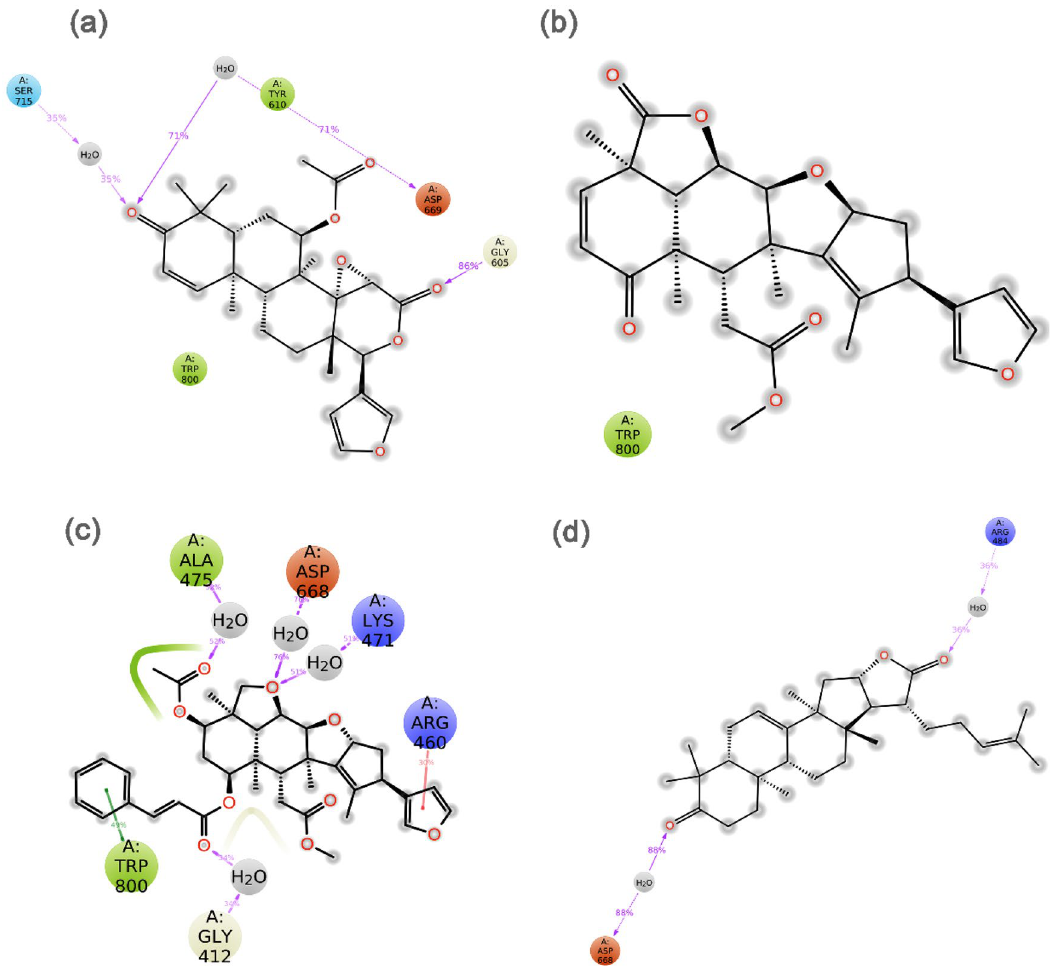
Figure 6. Schematic representation for interaction profile of jRdRp protein docked with bioactive compounds, i.e. ( a ) Gedunin, ( b ) Nimbolide, ( c ) Ohchinin acetate, and ( d ) Kulactone, extracted at 30% of total 100 ns simulation